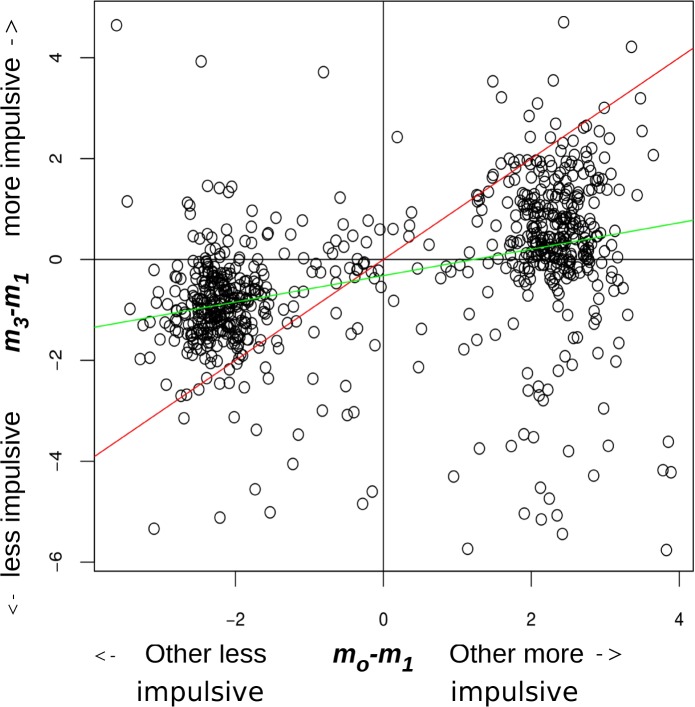
The difference between m-for-self after learning and before learning as a function of partner’s preference.This difference (ordinate) is plotted against the difference between m -for-other and m-for-self-before-learning. Two clusters form because we exposed participants to others that were 2.3 ln units away in modal preference (in either direction). Red is the identity line (fully adopting other's preference). Green is the linear regression line. It has a positive slope as expected (p ~ 0.0), but a negative intercept, denoting a slight overall bias for shifting towards more patient preferences.